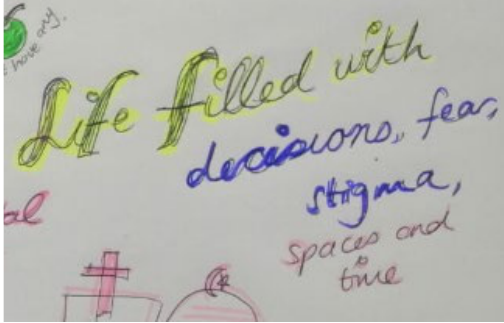
Figure 14. Decisions, fear, and stigma. Figure 15: Motivation to be healthy and adhere